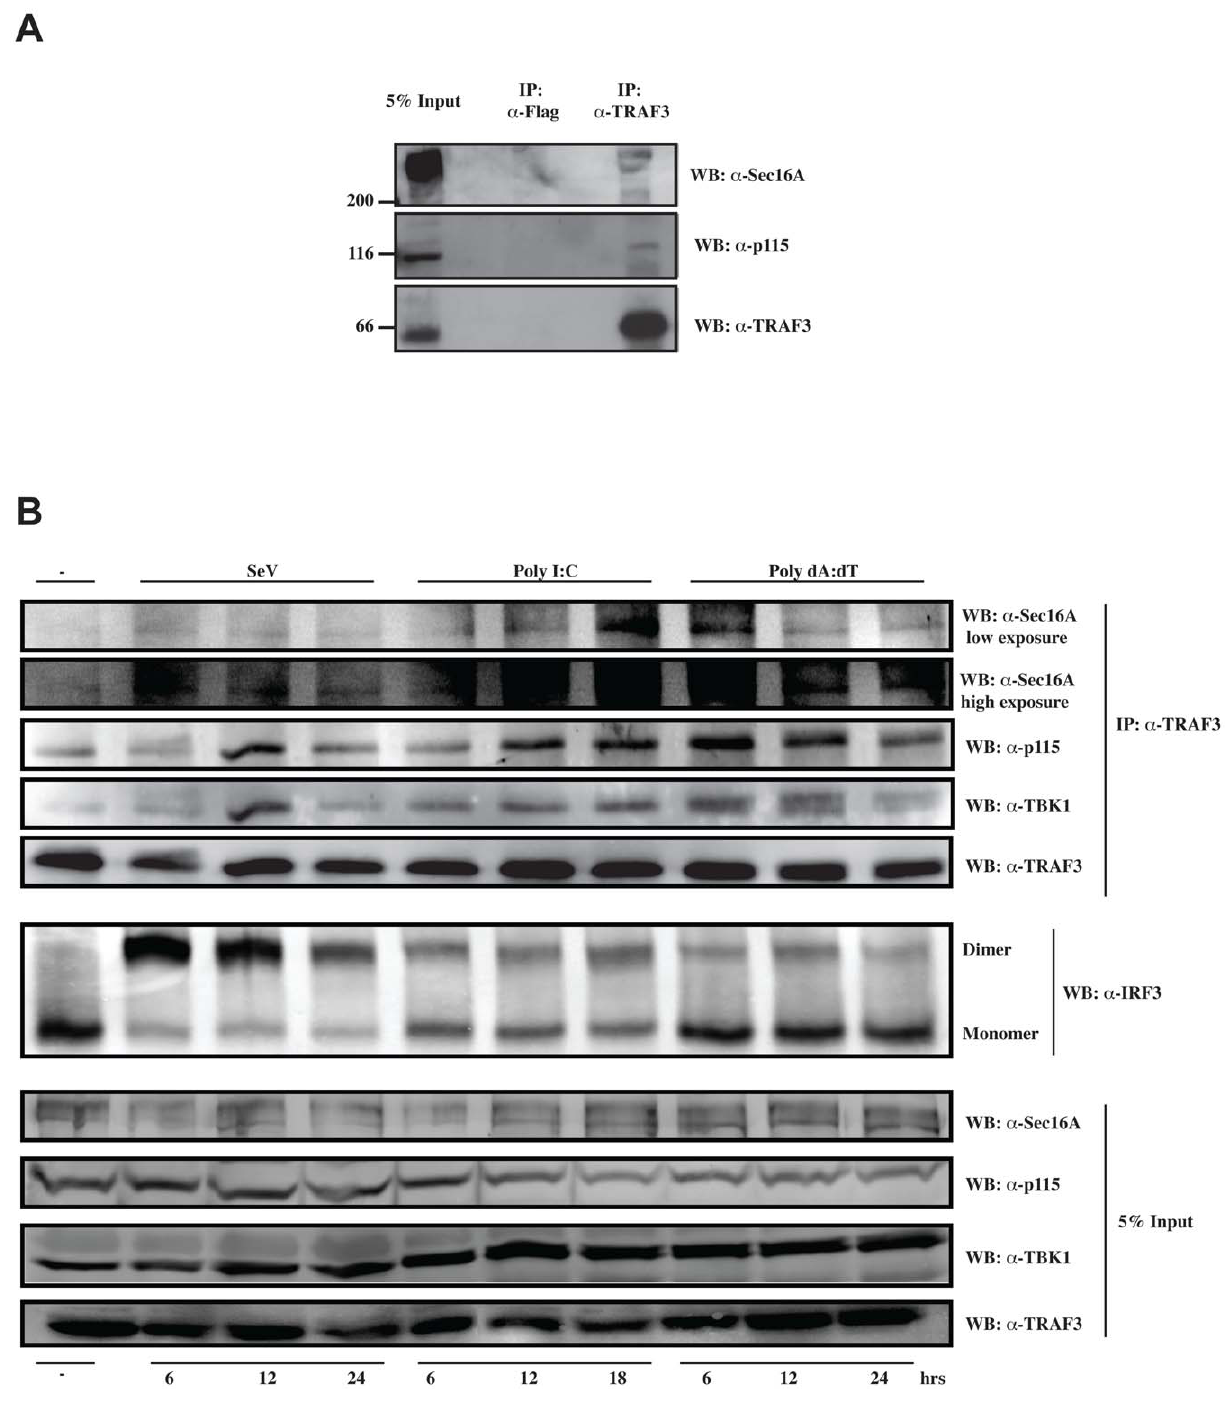
Figure 5. p115 and Sec16A associate with TRAF3 following cytosolic RNA and DNA sensor activation. ( A ) Whole-cell lysates (HeLa cells) were prepared and subjected to immunoprecipitation assays using TRAF3 (H-20) or isotype control antibodies followed by immunoblotting for the presence of p115, Sec16A, and TRAF3. ( B ) HeLa cells were treated as indicated for different periods of time. Whole-cell lysates were prepared and subjected to immunoprecipitation assays using TRAF3 (H-20) antibody followed by immunoblotting for the presence of p115, Sec16A, TBK1 and TRAF3. The Native-PAGE assay was conducted on the same cellular extracts to demonstrate the dimerization and activation of IRF-3 upon indicated treatments. One of three independent experiments with similar results is shown.